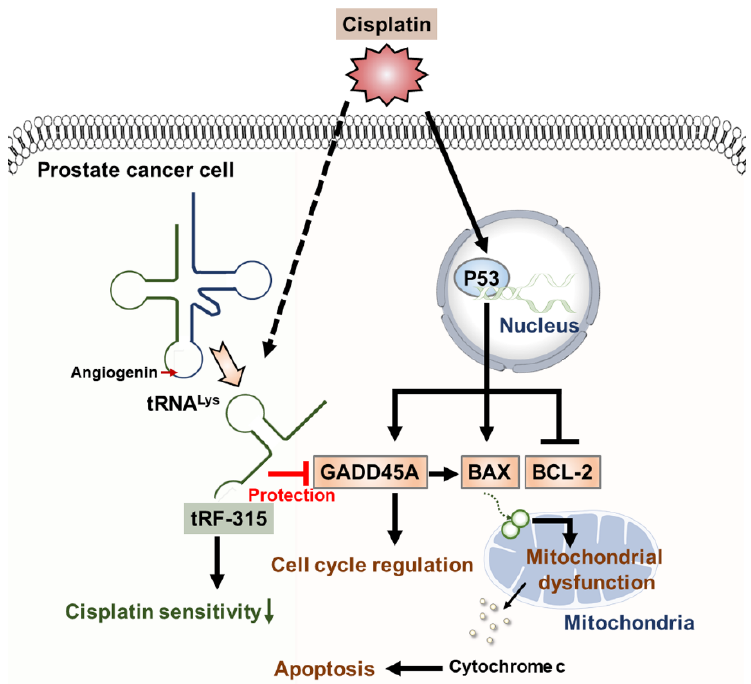
Figure 7. Schematic diagram describing the effects of tRF-315 on prostate cancer cells treated with cisplatin. Cisplatin induces the expression of GADD45A and BAX and inhibits the expression of BCL-2 mediated by P53 in prostate cancer cells. BAX leads to mitochondrial-dependent apoptosis. Meanwhile, in response to cisplatin, endogenous tRNA Lys are cleaved to tRF-315 due to the activity of angiogenin. GADD45A is the target gene for tRF-315. tRF-315 alleviates mitochondrial dysfunction and prevents apoptosis caused by cisplatin in prostate cancer cells. As a result, tRF-315 reduces the sensitivity of prostate cancer cells to cisplatin. Therefore, it is estimated that inhibition of tRF-315 can increase the sensitivity of cisplatin by regulating the expression of apoptosis-related proteins and inducing mitochondrial mediated apoptosis in prostate cancer cells.